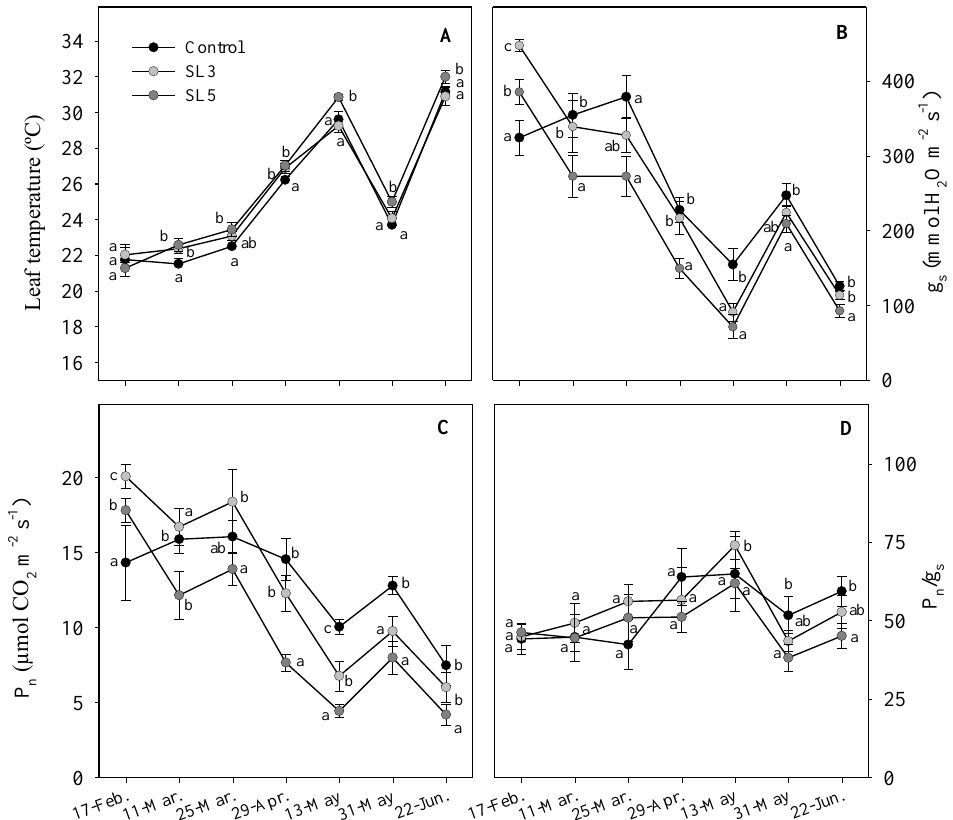
Figure 5. Leaf temperature ( A ), stomatal conductance at midday (g s ) ( B ), net photosynthesis rate at midday (P n ) ( C ), and intrinsic water use efficiency (P n /g s ) ( D ) of Hebe plants during the experiment, for control, SL3, and SL5 treatments. Control (1.8 dS m − 1 ), SL3 (3.3 dS m − 1 ), and SL5 (4.9 dS m − 1 ). Error bars indicate standard errors ( n = 6). For each measurement date, different letters indicate significant differences between treatments according to the LSD test at p ≤ 0.05.